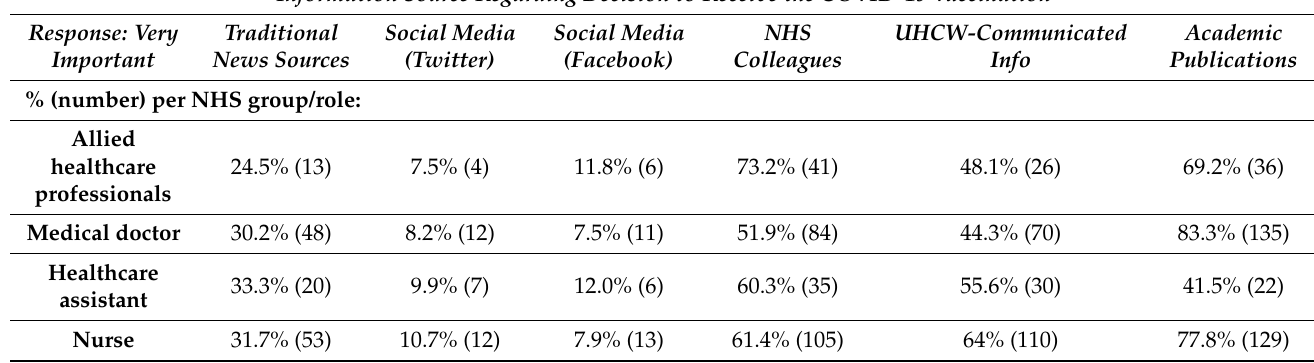
Table 2. Importance of information source regarding the decision to receive the COVID-19 vaccination based on staff group/role and ethnic